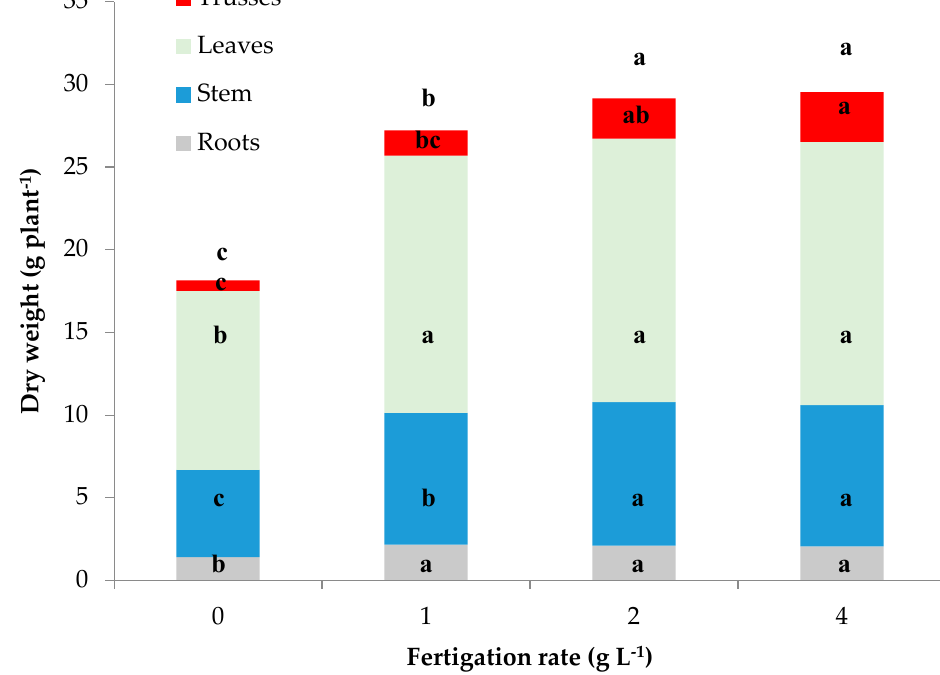
Figure 11. Effect of the nursery fertigation rates (g L − 1 of NPK 20-20-20) on the total, root, stem, leaves, and trusses dry biomass of Solanum lycopersicum ‘Marmande’ plants grown in soilless cultivation (bars of the same color with different letters are significantly different at p < 0.05 according to the LSD test).